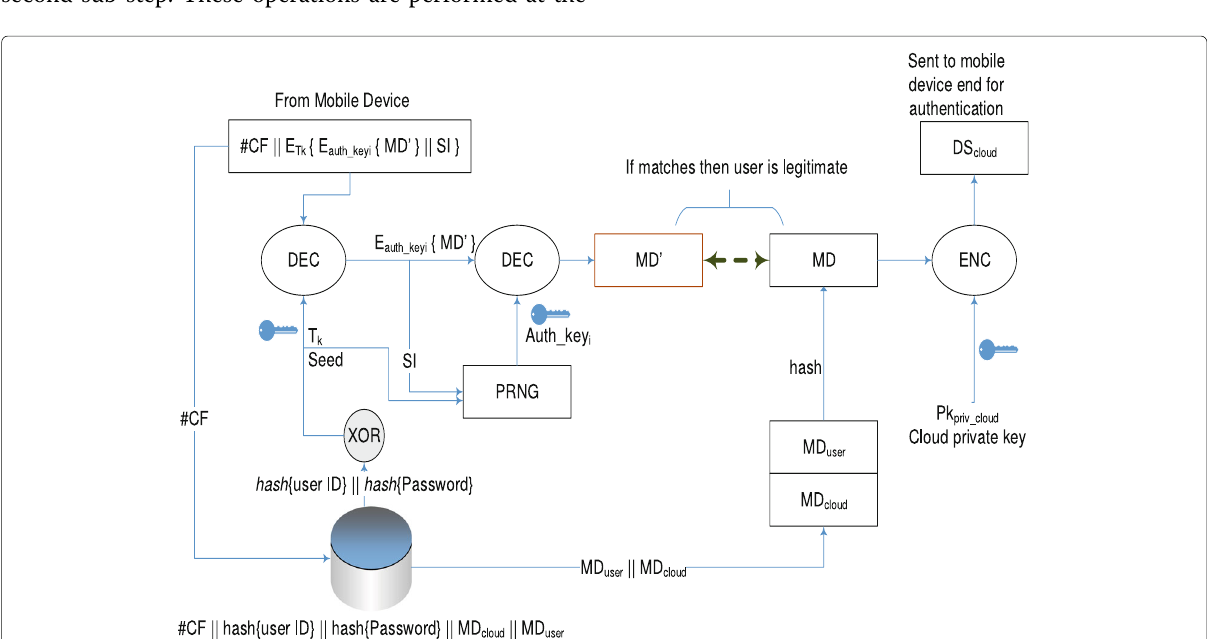
Fig. 2 Mobile device sends encrypted connect request # CF (cid:3) E T